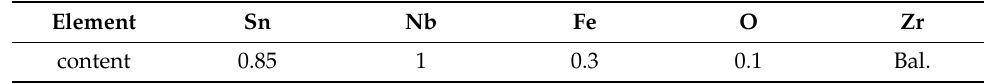
Table 1. Chemical composition of N36 zirconium alloy (wt.%). Element Sn Nb Fe O Zr content 0.85 1 0.3 0.1